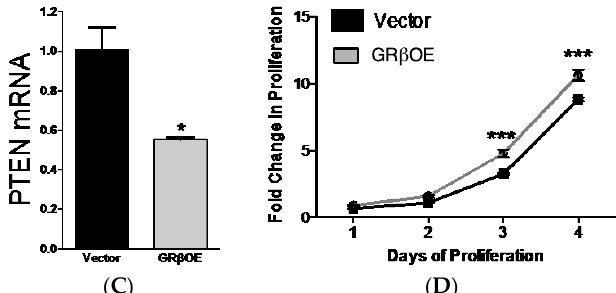
Figure 4. GRβ overexpression increases myogenic mRNA expression and proliferation . ( A ) MyoD and ( B ) Myogenin mRNA levels were significantly elevated in GRβOE myoblasts compared to vector . *** p = 0.0008, **** p < 0.0001; ( C ) PTEN mRNA levels were suppressed in GRβOE myoblasts . * p = 0.017. n = 3 to 6 experiments; ( D ) An MTT proliferation assay showed that GRβOE myoblast had an increase in proliferation at days 3 and 4 of assessment compared to vector. *** p = 0.0008 at day 3 and p = 0.0001 at day 4 between cells types and the time point indicated. n = 3 experiments per time point. Data expressed as mean RQ ± SEM for real time PCR analysis and mean fold change ± SEM for proliferation.